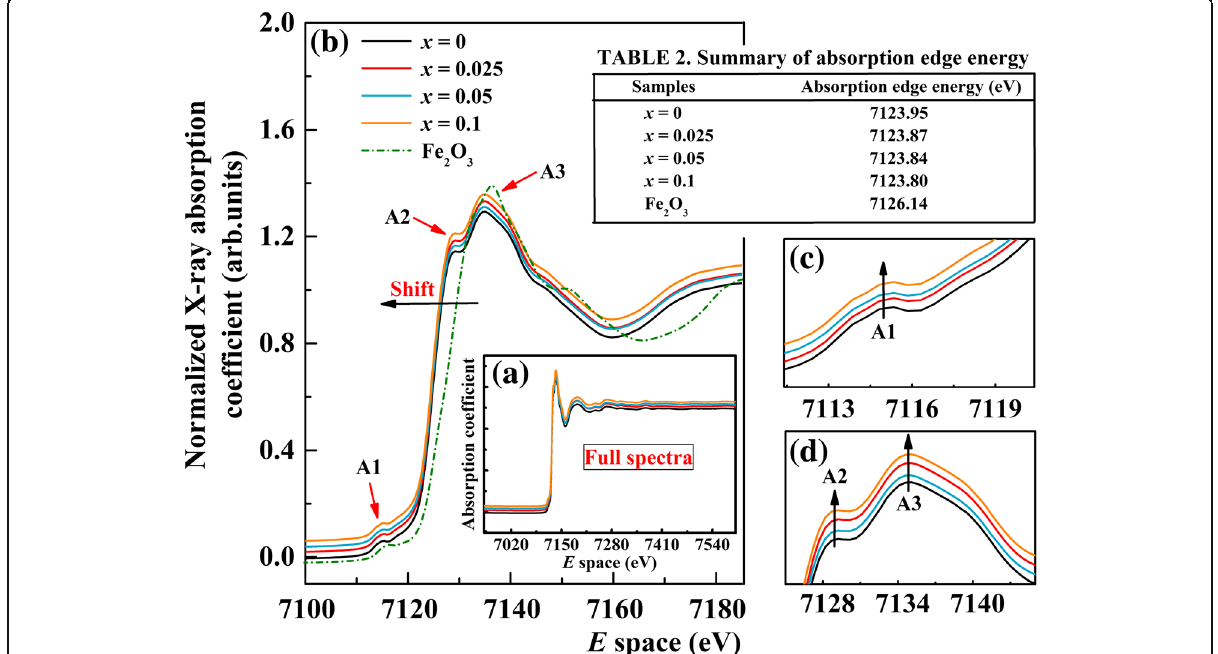
Fig. 3 a Fe K -edge XANES spectra of BFA x O (0 ≤ x ≤ 0.1) and reference Fe 2 O 3 . b XANES spectrum in the range of 7100 – 7180 eV. c Enlarged view of the peak A. d Peak B and peak